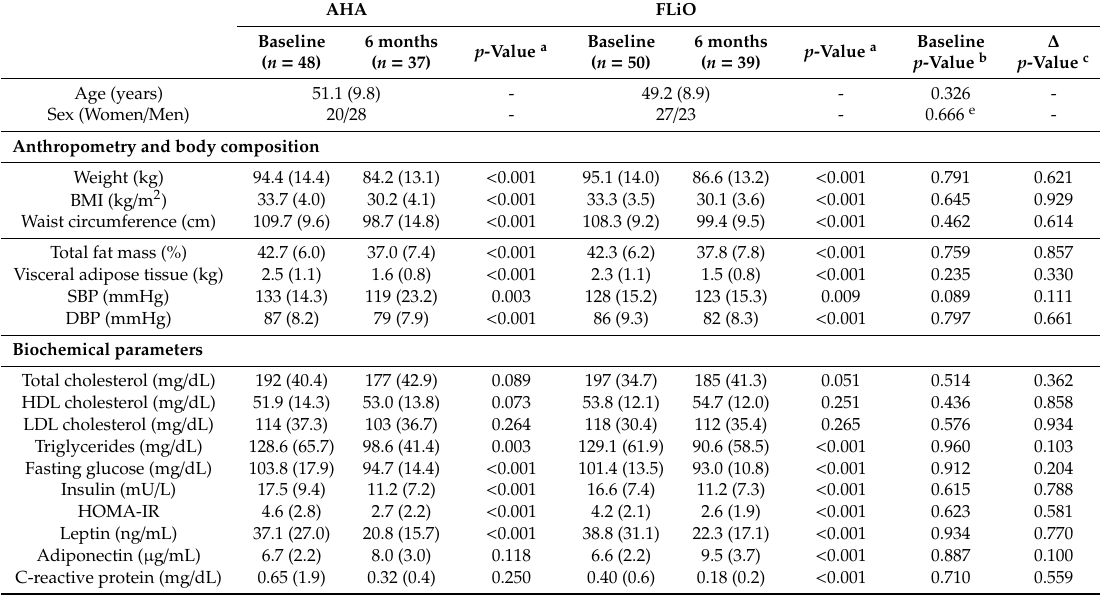
Table 1. Characteristics at baseline and after 6 months of dietary intervention in subjects with NAFLD according to the group of intervention.